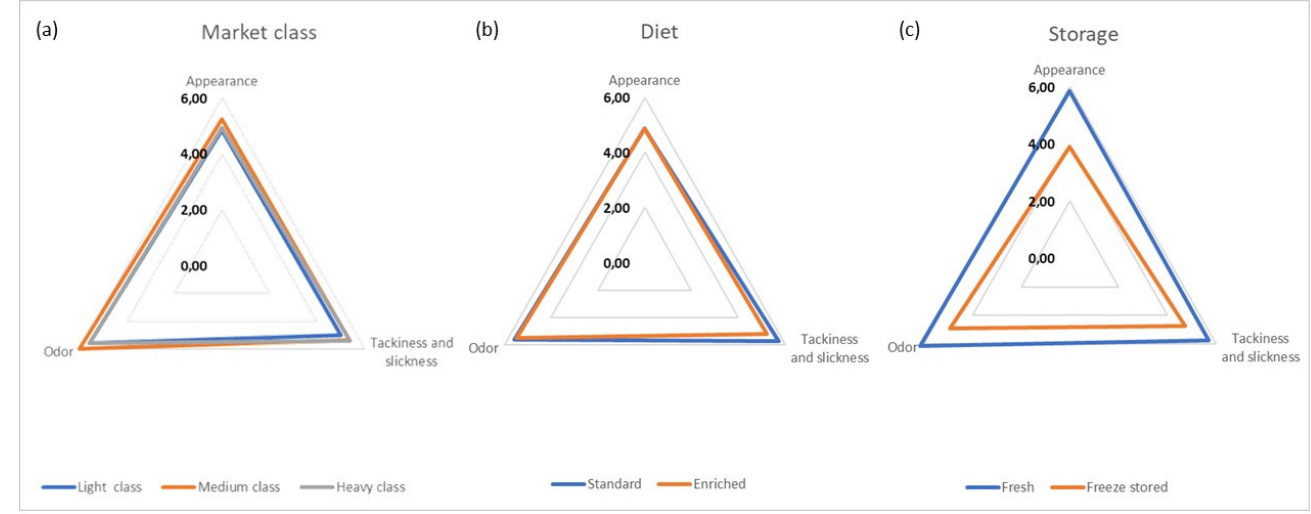
Figure 2. Sensory analysis of control and functional breast fillets from light, medium and heavy broilers at 24 h post-mortem and after freeze storage for 30 days (raw state). For every market class ( a ), data are reported in terms of mean ± standard deviation of n = 28 tastings of breast meat from broilers receiving standard ( n = 14) and experimental ( n = 14) feeding, both at 24 h post-mortem ( n = 14) and following freeze storage ( n = 14). For the dietary treatment ( b ), data are expressed as mean ± standard deviation of n = 42 tastings of meat from light ( n = 14), medium ( n = 14) and heavy ( n = 14) broilers, both in fresh status ( n = 21) and after freeze storage ( n = 21). For fresh or freeze stored samples ( c ), data are expressed as mean ± standard deviation of n = 42 tastings of meat from light ( n = 14), medium ( n = 14) and heavy ( n = 14) broilers receiving both standard ( n = 21) and functional ( n = 21) feed.